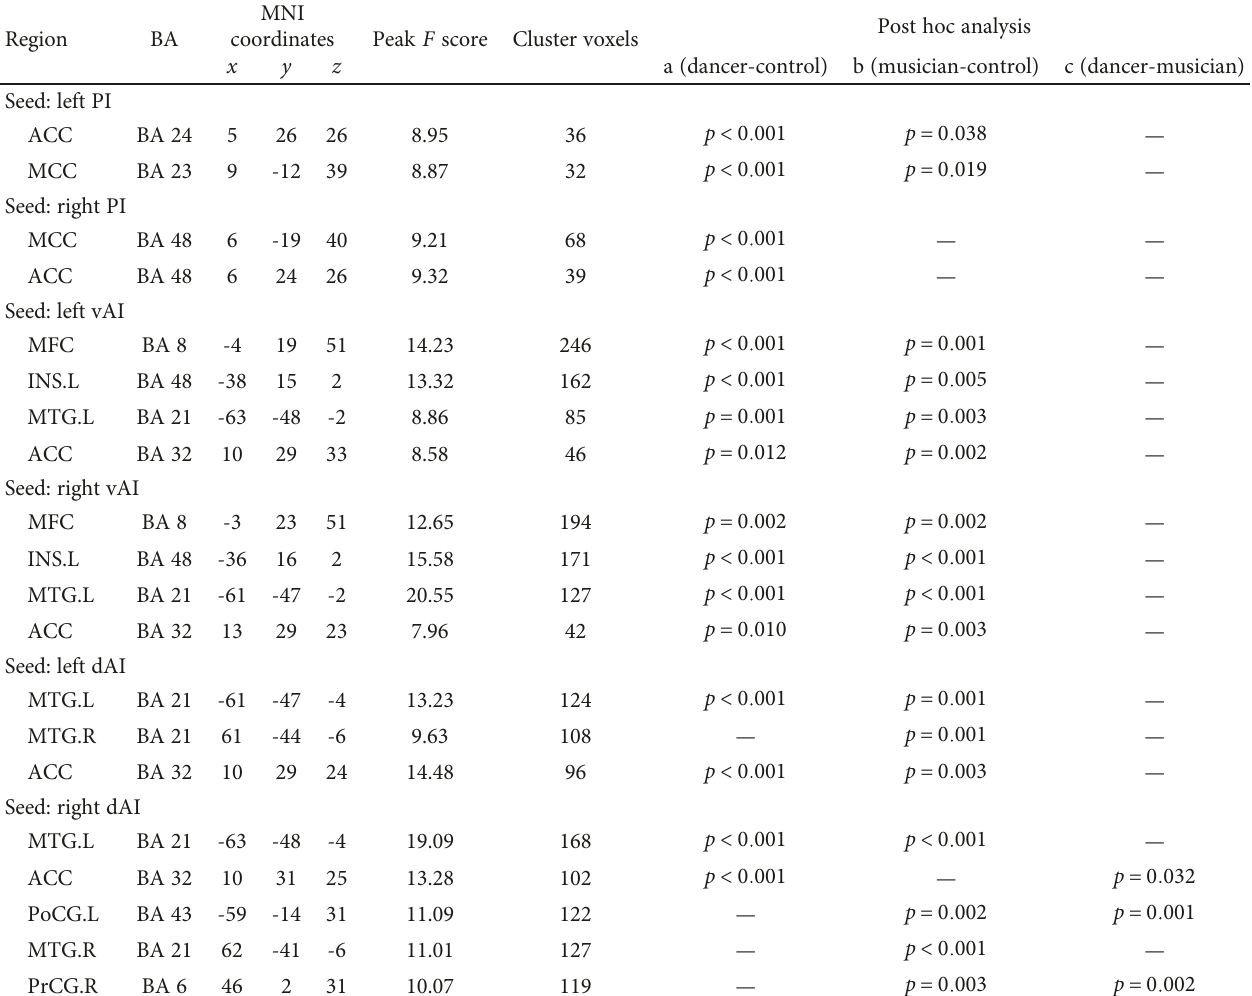
Table 3: Insular subdivision connectivity in dancers, musicians, and